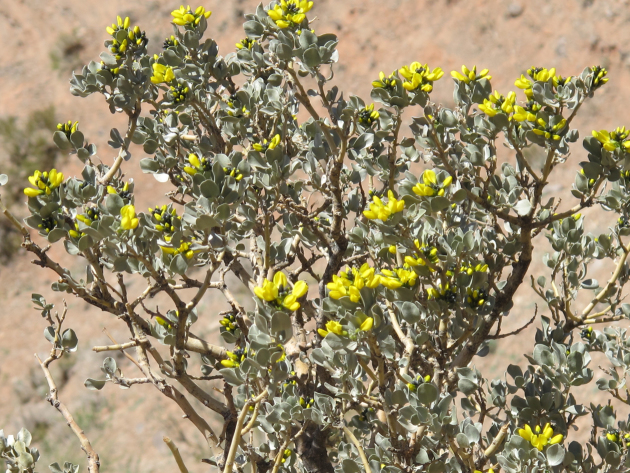
A flowering A. nanus.